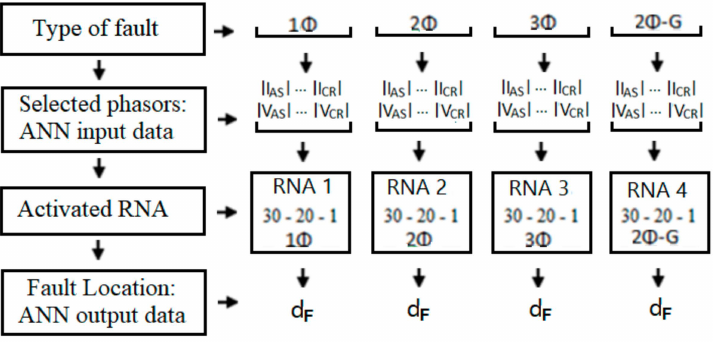
Figure 9. The Modular structure of fault location